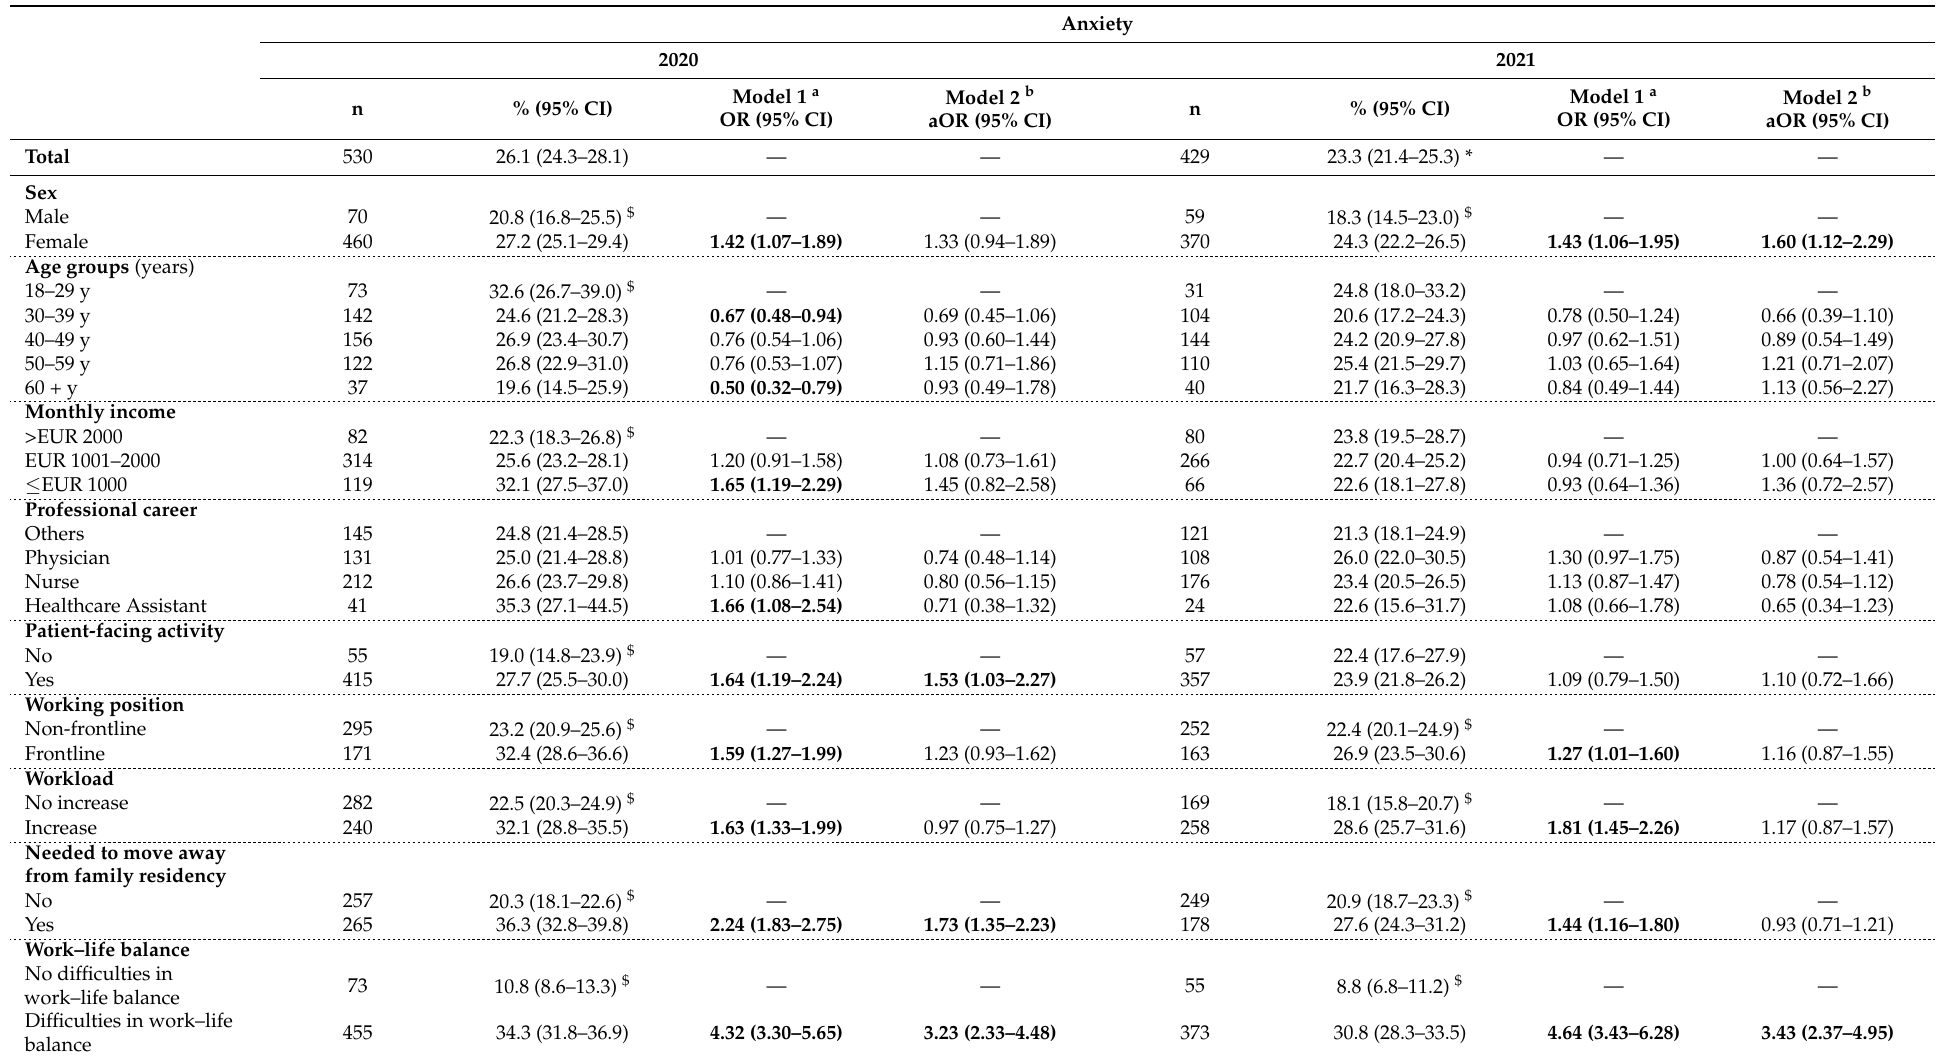
Table 2. Moderate to severe symptoms of anxiety among HCPs during the first two years of COVID-19 pandemic in